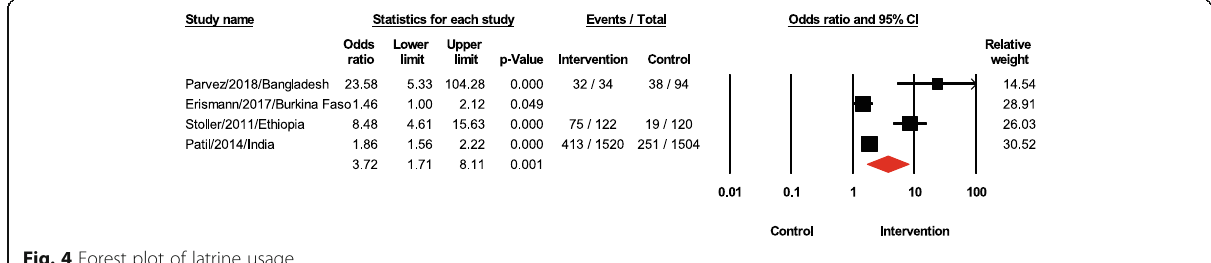
Fig. 4 Forest plot of latrine usage